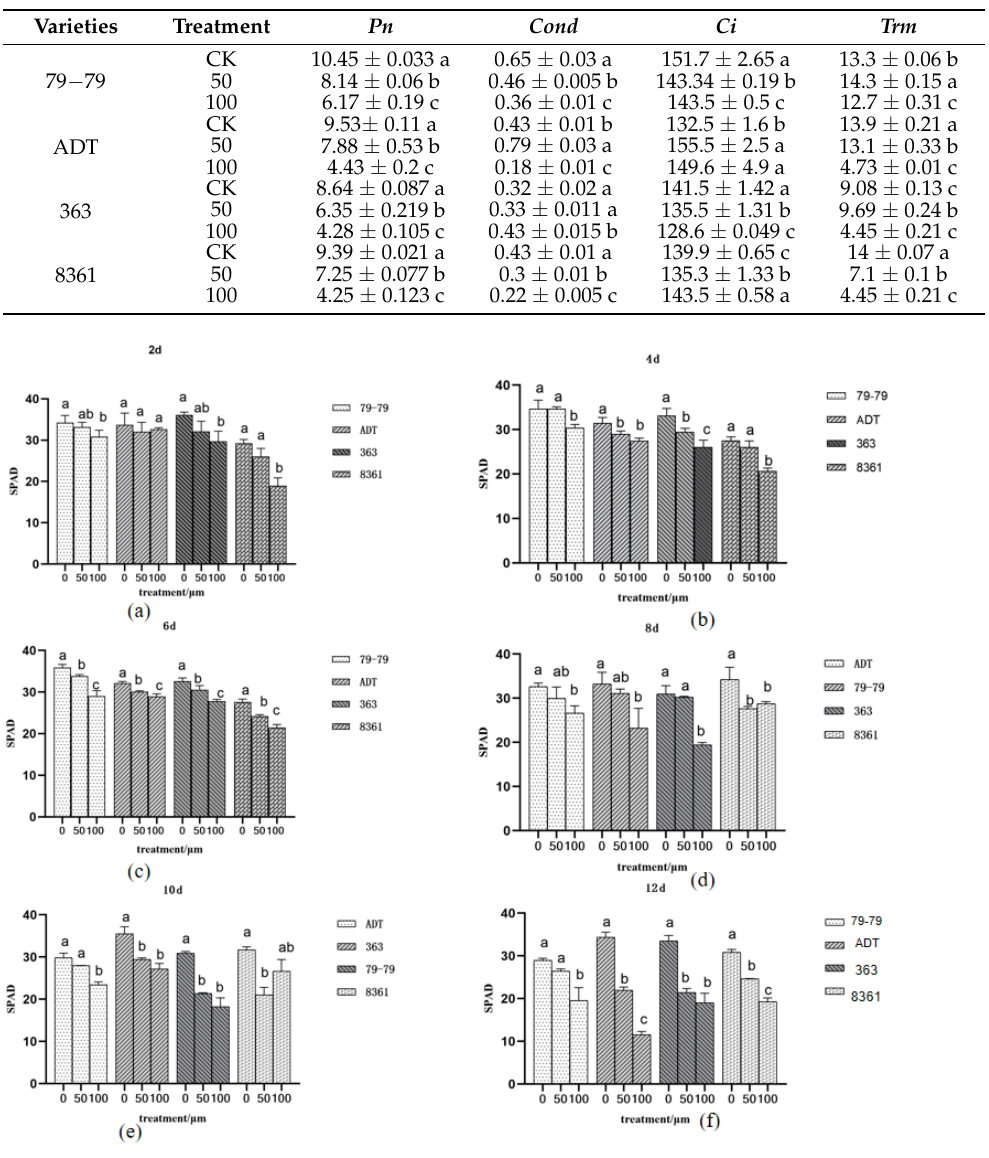
Figure 4. Changes in the SPAD after 2, 4, 6, 8, 10, and 12 days of cadmium treatment. Within each sunflower varieties, the different letters indicate a significant difference at the p < 0.05 level, according to Duncan’s multiple range test. ( a ) is 2d, ( b ) is 4d, ( c ) is 6d, ( d ) is 8d, ( e ) is 10d, ( f ) is 12d.